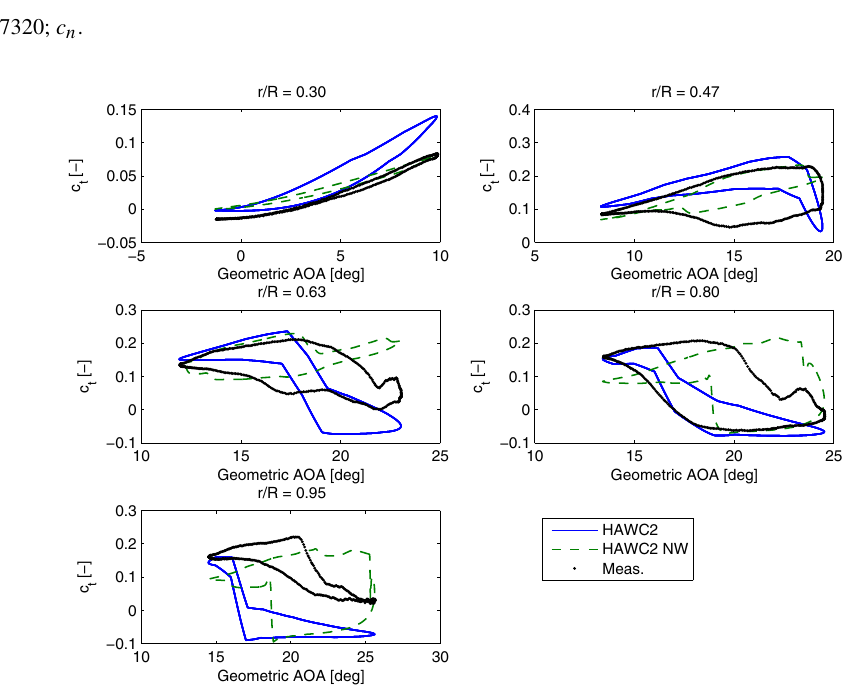
Figure 9. Case O47320; c t .